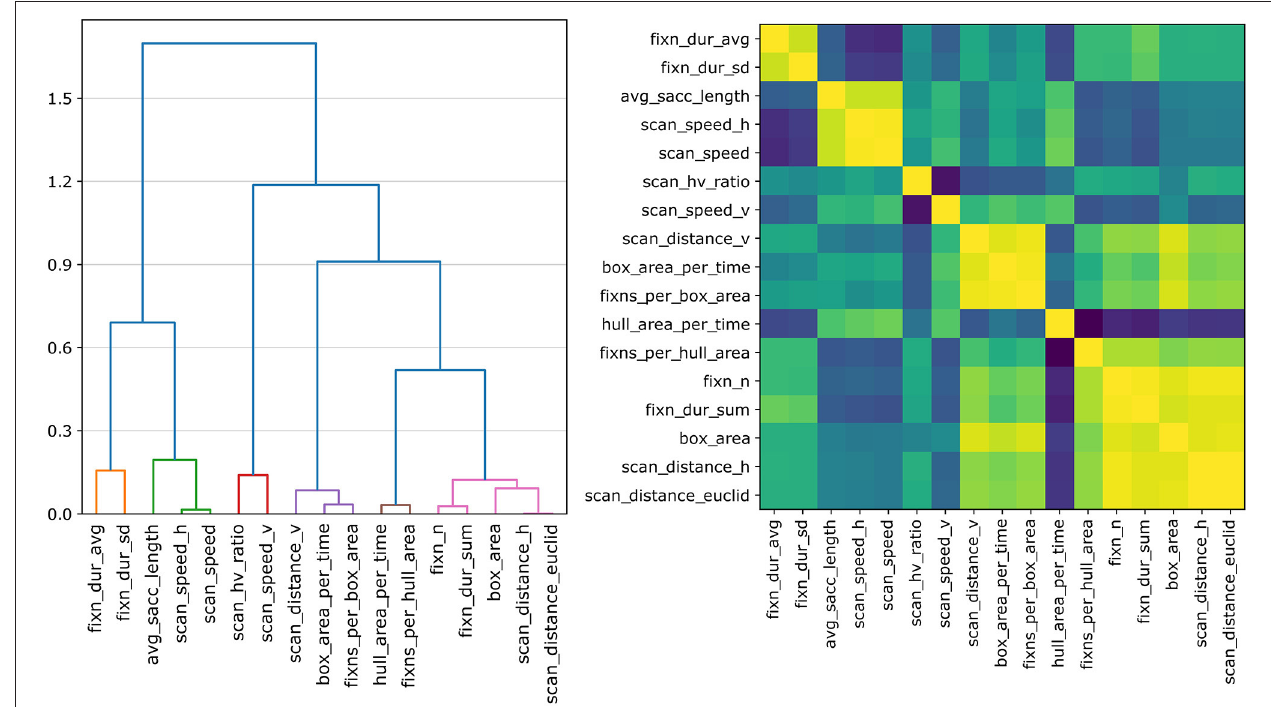
FIGURE 4 | The heatmap (right) shows the pairwise Spearman rank-order correlations for our features using all samples of the g-REL data. The dendrogram (left) shows feature groupings based on their correlation-based distances. Setting the distance threshold to t = 0.3 yields six feature clusters (see colored